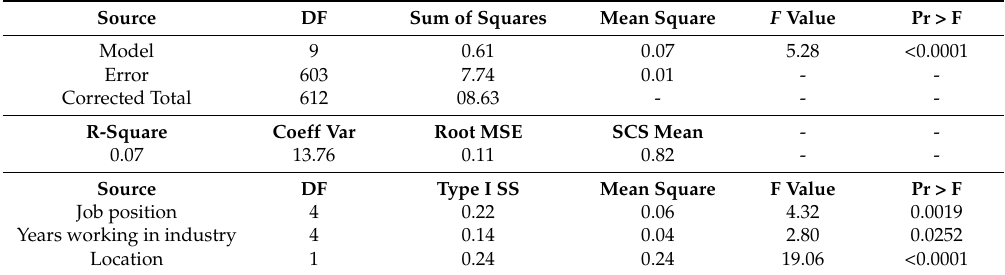
Table 3. ANACOVA Final Model: The Generalized Linear Model (GLM) Procedure. Source